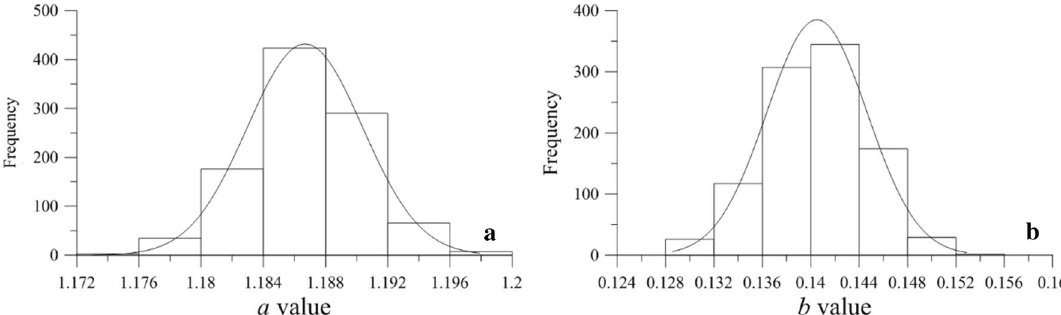
Fig. 6 The histogram of obtained values of a and b from MC simulation